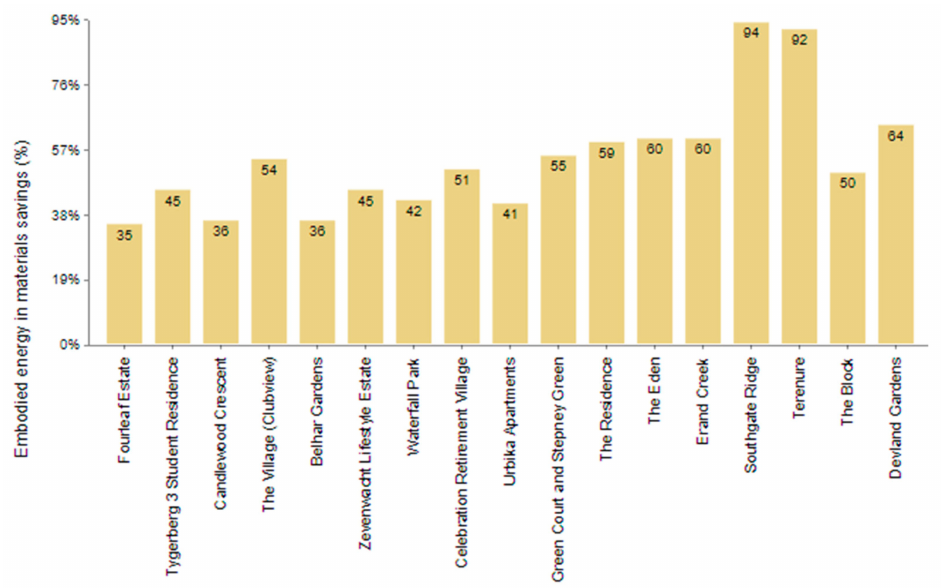
Figure 3. Embodied energy in materials savings (%) of the 17 South African residential complexes with EDGE certification.